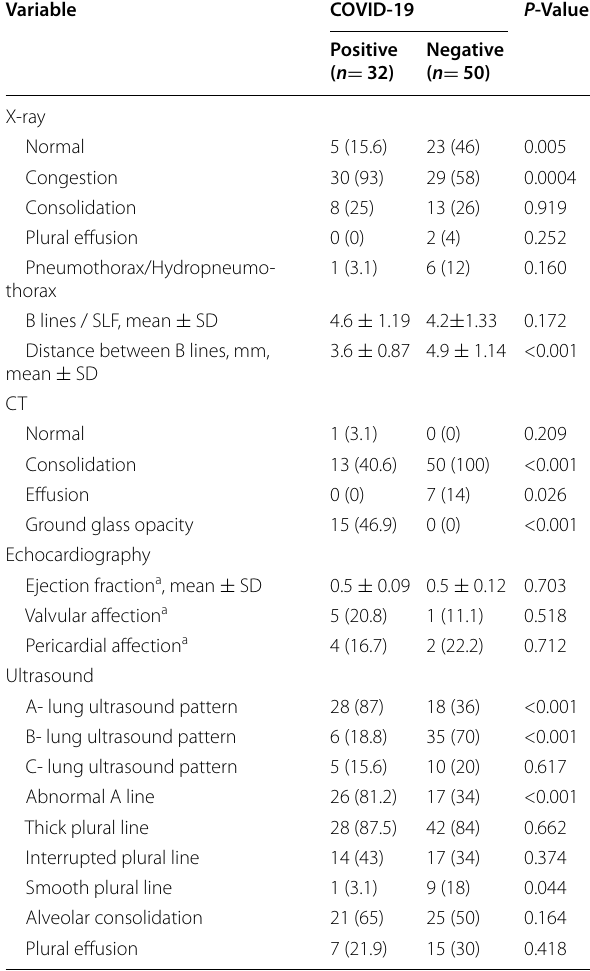
Table 2 Imaging findings